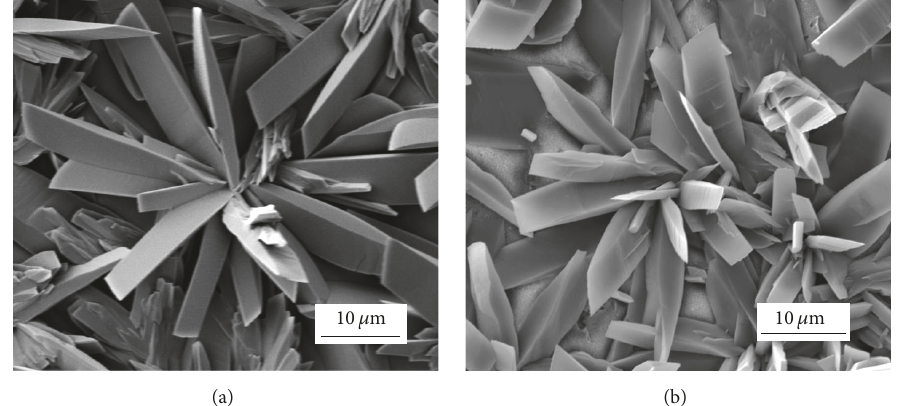
Figure 2: SEM images of the Alq 3 microbelts on the one-step (a) and two-step (b) APA surface. The crystals were formed by treating the APA samples in a 10mM HQ solution at 100 ∘ C for 3min.